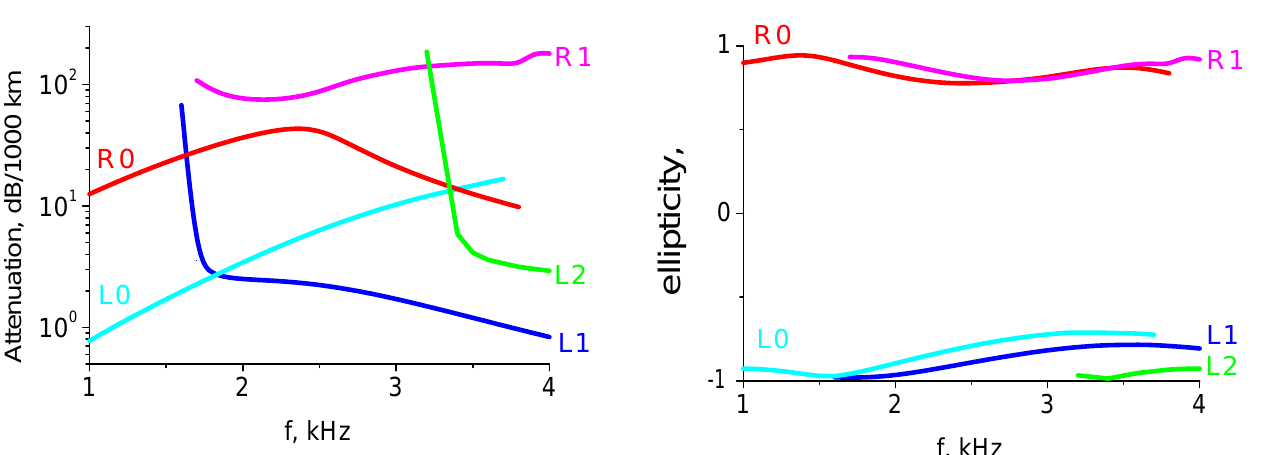
Fig. 6c. Polarization of different modes for the night IRI model of